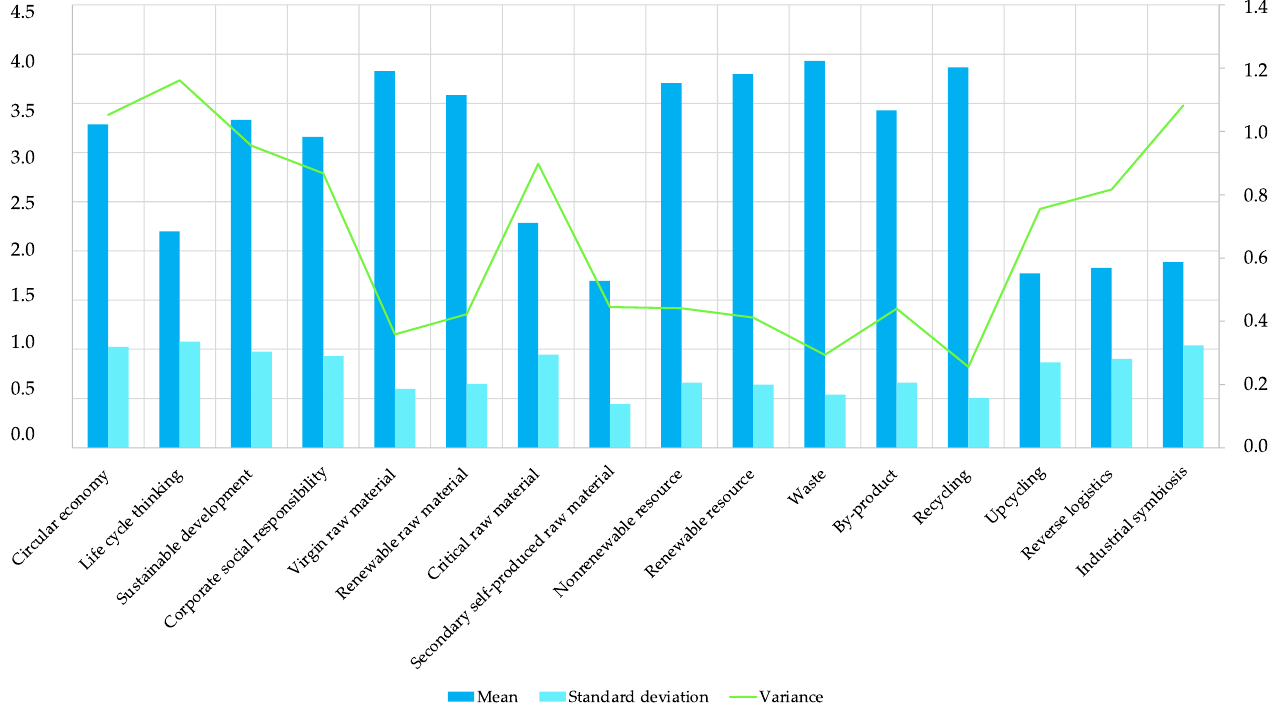
Figure 2. Awareness on the Sustainability Issues by Mean, Standard Deviation and Variance. Source: Personal elaboration by the authors. Table 5. Users’ Perception on Selected Circularity Indicators by